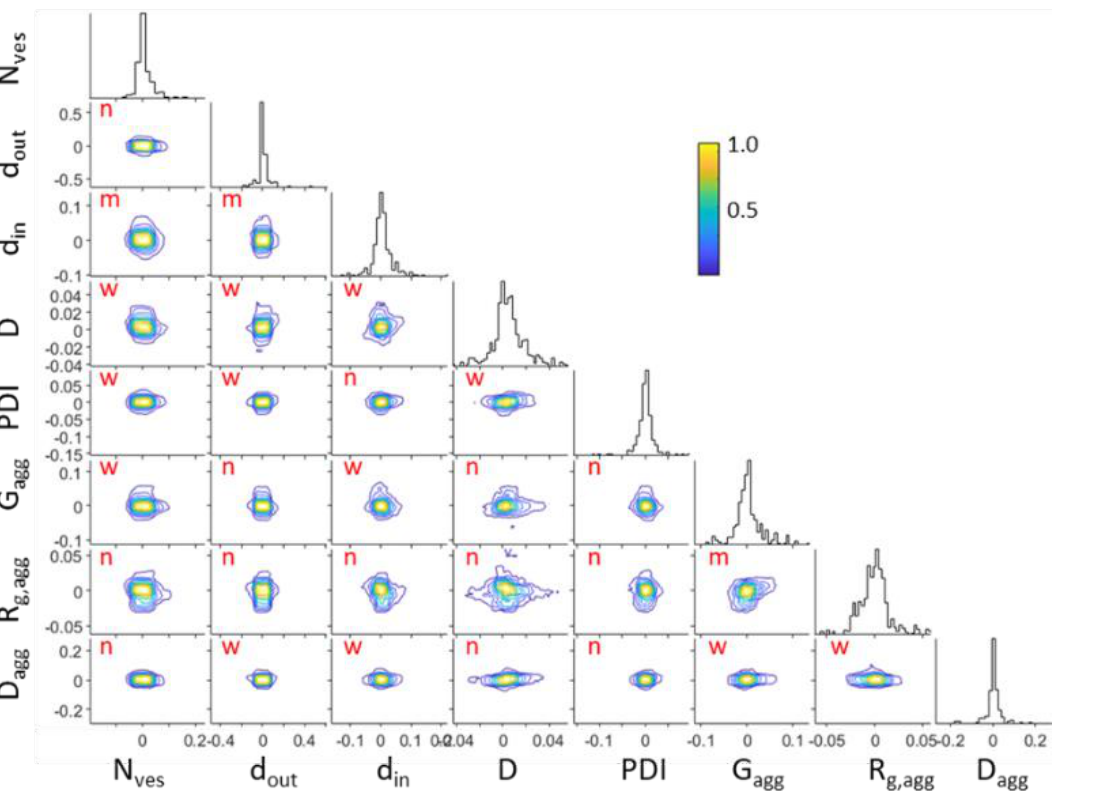
Figure 6. Corner plots of fitted parameters from DPPC/PEO-b-PCL1 at 30 mg mL −1 at 25 °C. Interdependencies are shown as “n” for negligible, “w” for weak and “m” for moderate.